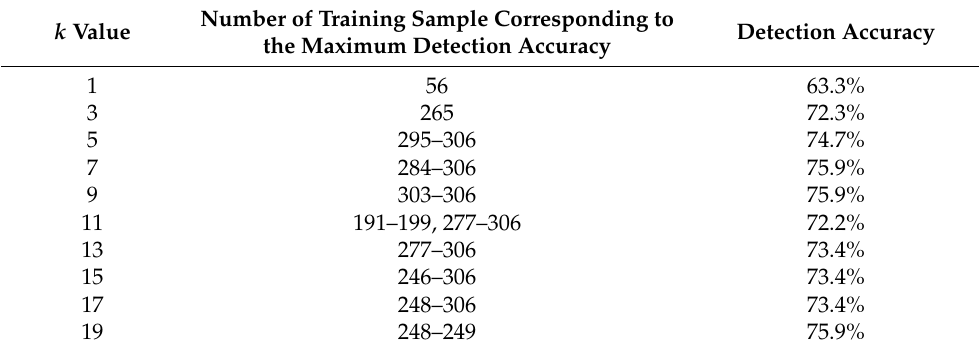
Figure 2. Accuracy of fatigue driving behavior detection with the number of training sample when 𝑘 takes different values. Table 4. The maximum value of the fatigue driving detection accuracy when 𝑘 takes different values and the corresponding number of training samples.